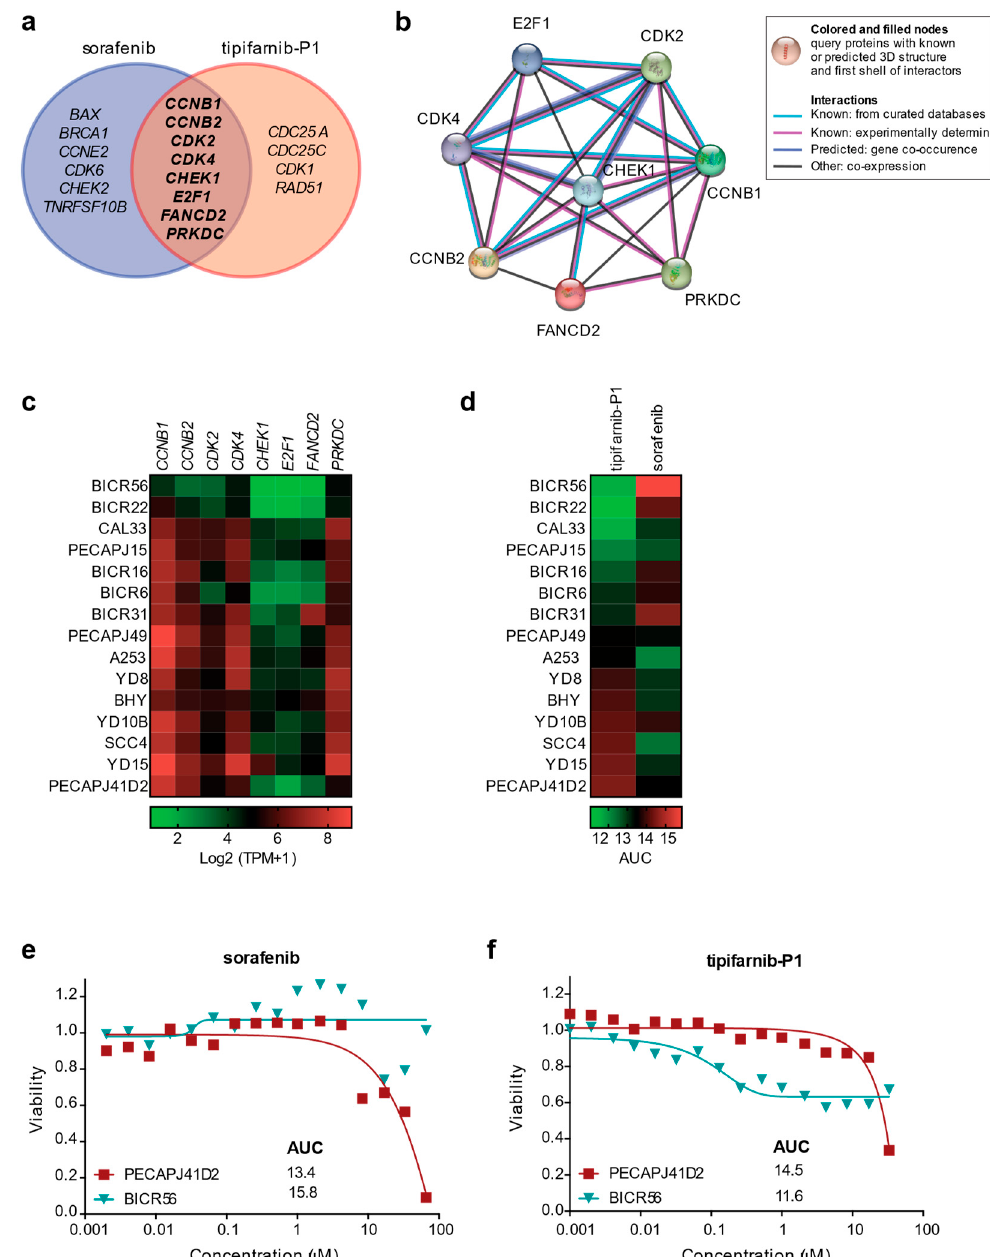
Figure 6. Gene signature of drug response in OSCC cell lines. ( a ) Venn diagram showing the integration of the response signature to sorafenib and tipifarnib-P1. ( b ) STRING protein–protein interaction networks functional enrichment analysis of eight DDR genes correlated to drug response identified in ( a ). ( c ) Heatmap depicting mRNA expression of eight DDR genes in OSCC cell lines. TPM, transcript per kilobase million. ( d ) Heatmap showing drug response to tipifarnib-P1 and sorafenib in OSCC cell lines. AUC, area under the curve. ( e , f ) Drug response curve to ( e ) sorafenib and ( f ) tipifarnib-P1 in two selected OSCC cell lines, expressing low (BICR56) and high (PECAPJ41D2) mRNA levels of DDR genes retrieved from drug sensitivity AUC (CTD ^2).